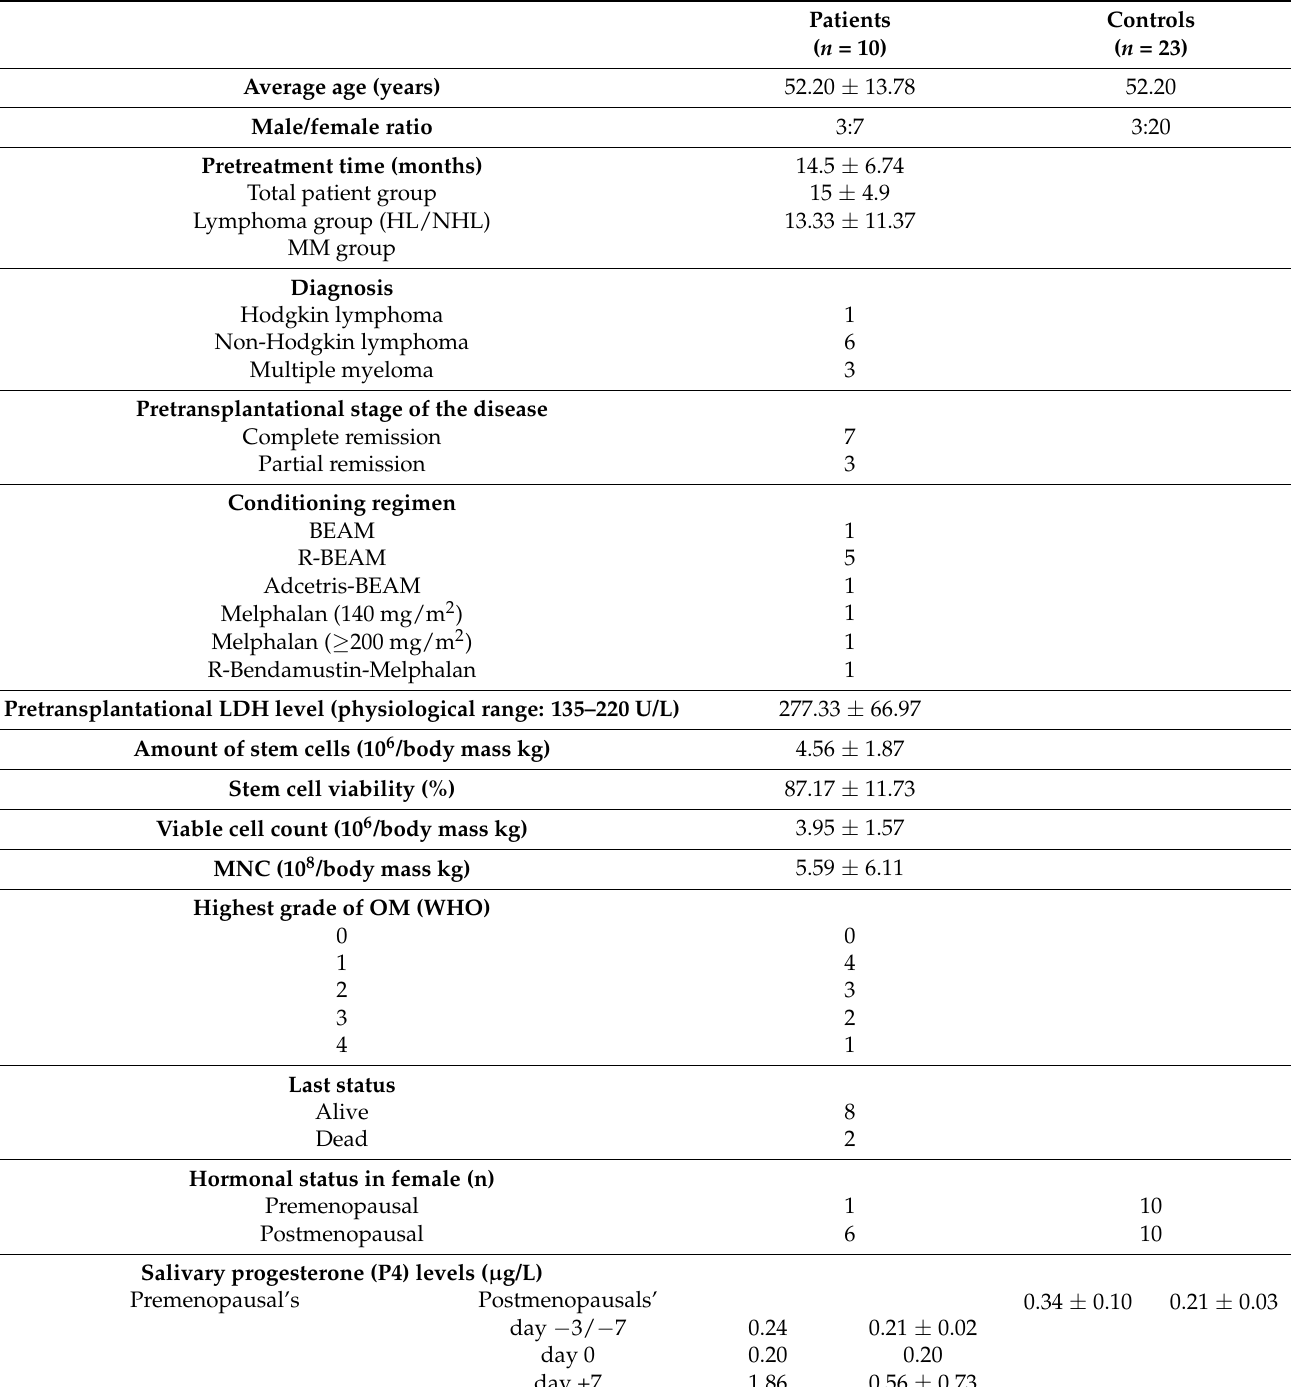
Table 1. Demographic and clinical data of